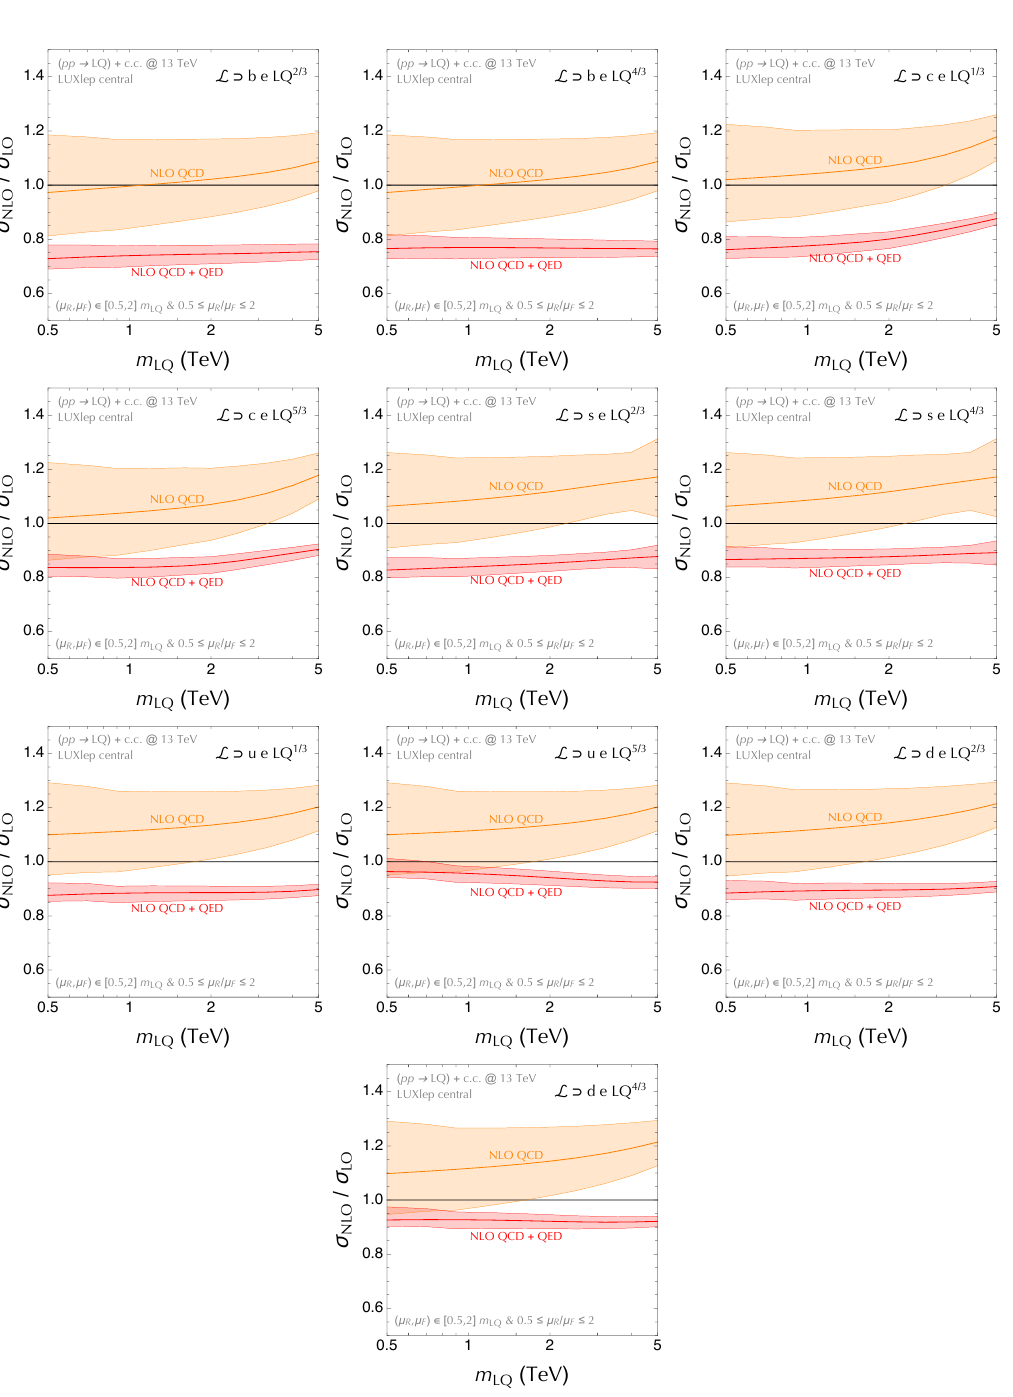
Figure 8 . ( electron ) NLO K -factors ( σ NLO /σ LO ) for resonant scalar leptoquark production at 13 TeV LHC. Shown with orange (red) are the NLO QCD (NLO QCD + QED) predictions normalised to the LO when setting the central scales to µ R = µ F = m LQ . The colored bands are obtained by varying factorisation and renormalisation scales in the NLO calculations within { µ F , µ R } ∈ [0 . 5 , 2] m LQ while respecting 1 / 2 ≤ µ R /µ F ≤ 2 . We use the central PDF set from LUXlep-NNPDF31_nlo_as_0118_luxqed (v2)